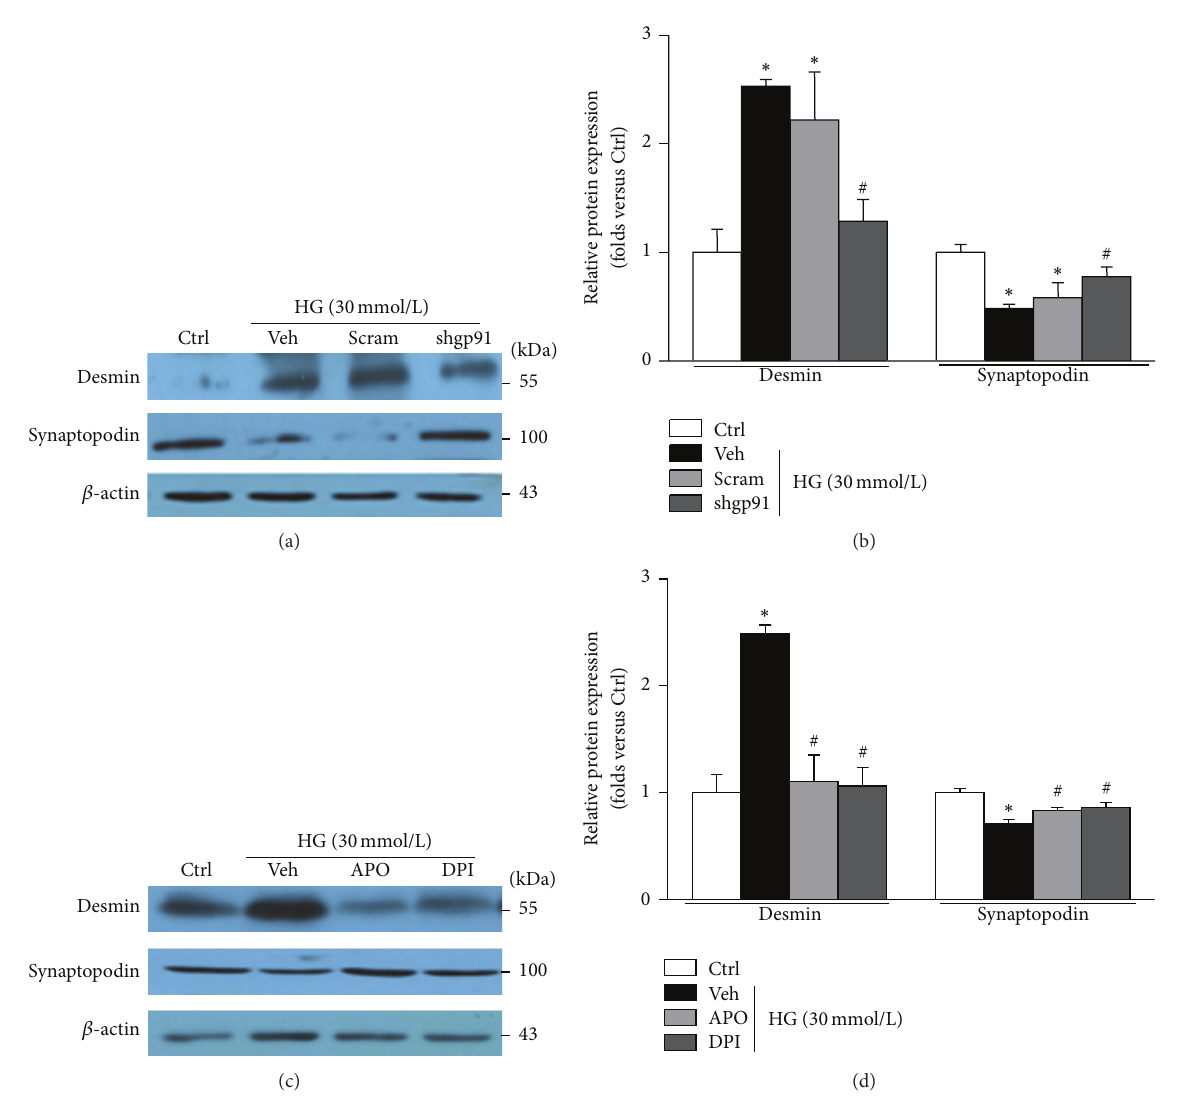
Figure 5: Genetic or pharmacologic inhibition of NADPH oxidase alleviates HG-induced podocyte injury. (a) Western blotting gel documents showing the effect of gp 91 𝑝ℎ𝑜𝑥 gene deletion on desmin and synaptopodin expression in cultured human podocytes with HG treatment. (b) Summarized data of protein expression of desmin and synaptopodin in podocytes ( 𝑛 = 4–6). (c) Western blot analysis showing the effect of APO and DPI on desmin and synaptopodin expression in podocytes exposed to HG. (d) Summarized data of the abundance of desmin and synaptopodin protein in HG-exposed podocytes treated with APO or DPI ( 𝑛 = 4–8). Ctrl: control; HG: high glucose; Veh: vehicle; Scram: scrambled shRNA; shgp91: gp 91 𝑝ℎ𝑜𝑥 shRNA; APO: apocynin; DPI: diphenyleneiodonium. ∗ 𝑃 < 0.05 compared with Ctrl; # 𝑃 < 0.05 compared with HG group treated with vehicle or transfected with scramble